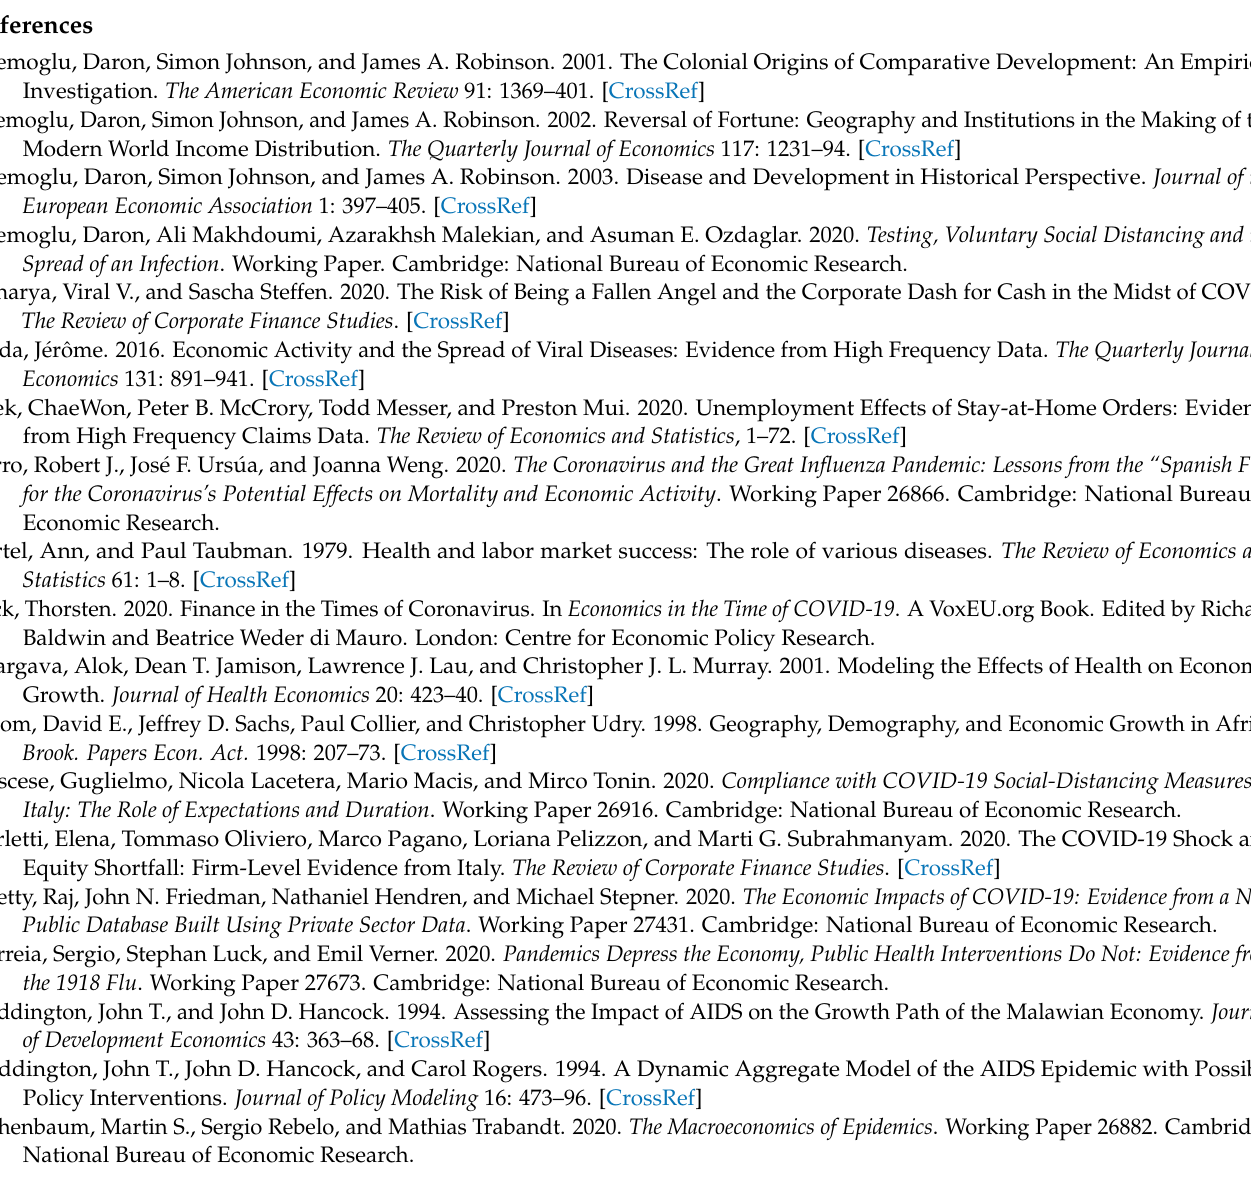
the treatment (the “pandemic”). We defined two sets of treated groups based on the median value of the disease severity variables in the state-level sample using cases or deaths. Cases categorize countries as treated when they have above-median values of COVID-19 confirmed cases per million and categorize them as the control group otherwise. Deaths categorize countries as treated when they have above-median values of COVID-19 confirmed deaths per million and categorize them as the control group otherwise. Table 1 provides variable definitions. The p -values are reported beneath the coefficient estimates.